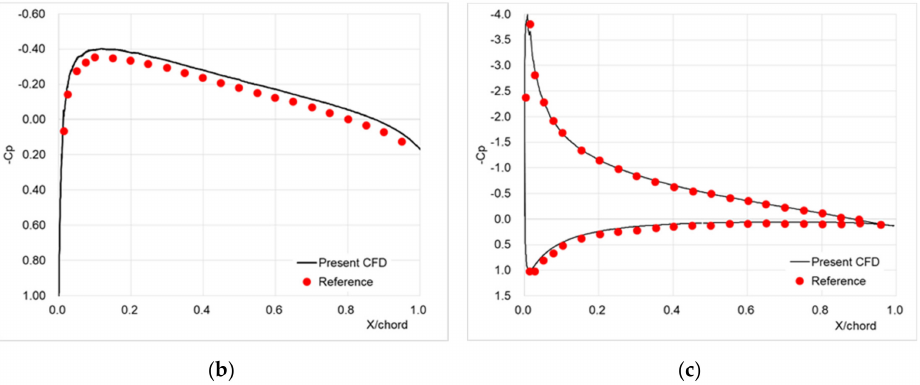
Figure 1. Comparison of surface pressure distributions obtained using the current CFD analysis with those of the wind tunnel test [21]: ( a ) Partial view of computational meshes. Pressure distributions at angle of attack of ( b ) 0 ◦ and ( c ) 10 ◦ .